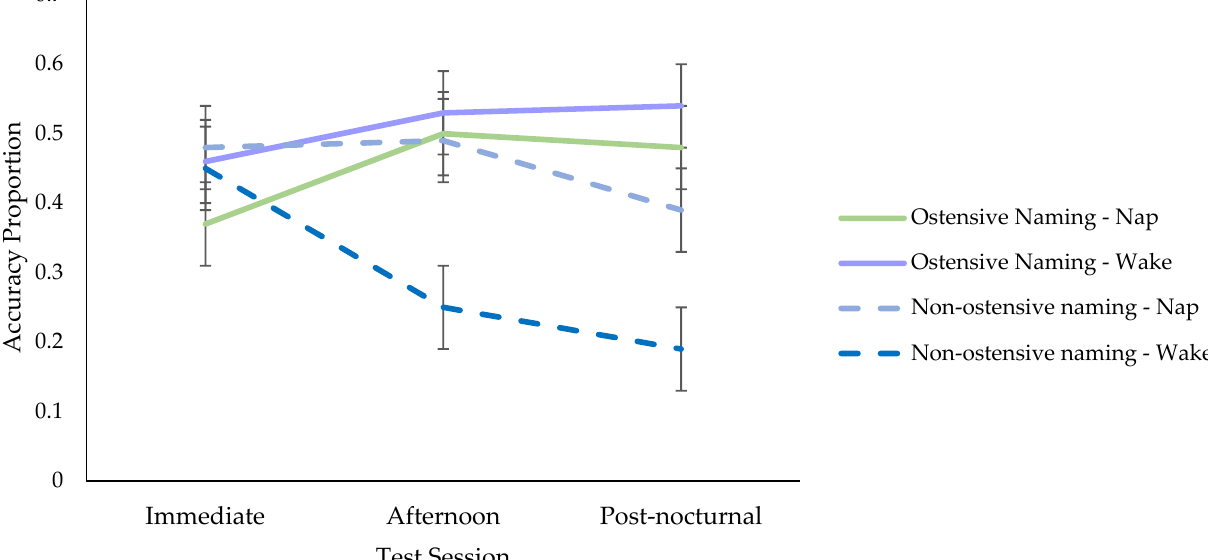
Figure 5. Retention Across Test Sessions in the Ostensive Naming and Non-Ostensive Naming Groups.